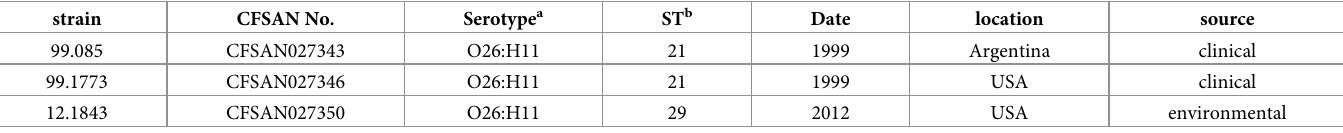
Table 1. Summary of the characteristics of the 3 STEC O26:H11 strains sequenced in this study. strain CFSAN No. Serotype a ST